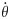
Posture task.The model represents an animal recovering its posture after a perturbation. (a) We use an inverted pendulum with a point-mass body and massless rigid legs, pivoting about a ground-mounted pin joint. Our model considers limb length (Llimb), mass of animal (M), and actuating muscle torque (Tmusc). (b) Angle (θ), angular velocity (θ˙), and torque (Tmusc) profiles in the posture task for a one kg animal for movement of 0.21 dimensionless velocity, the perturbation size for which inertial delay equals sensorimotor delay in a one kg animal. (c) Variation in coefficient a and exponent b of the power law for inertial delay determined from numerical simulations with perturbation size (red), sensorimotor delay (dark green), and theoretical predictions for the inertial delay exponent based on scaling of muscle force with cross-sectional area ∝M2/3 (thick dashed line) and dynamic similarity ∝M1 (thin dashed line).